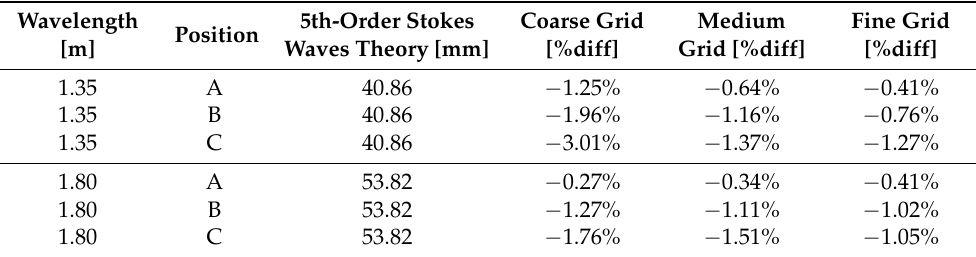
Table 4. Comparison of wave amplitude for each position according to the grid system.